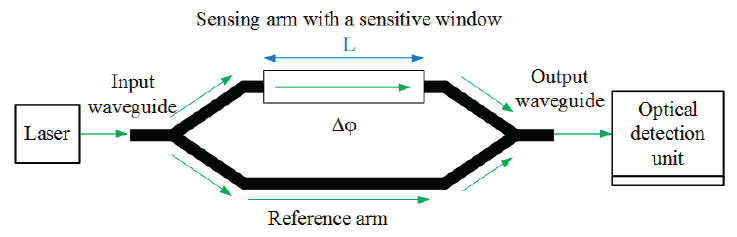
Figure 1. The schematic diagram of a typical Mach-Zehnder interferometer (MZI) sensor based on optical